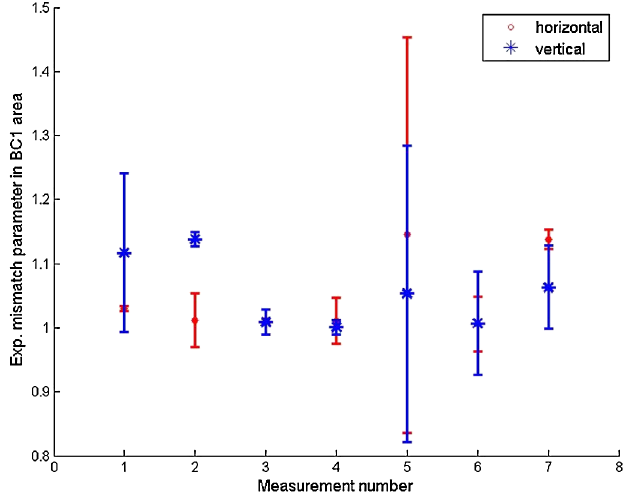
FIG. 6. Betatron mismatch parameter measured at one location in the BC1 area vs measurement number. Each value is the result of a single measurement of the Twiss parameters. The mismatch parameter is measured after the matching loop has been per- formed with ELEGANT and the quadrupole strengths applied in the BC1 area. (Notice that central values smaller than 1 have not physical sense: the full range of the vertical axis is used to show the full error bars associated with the measurements).